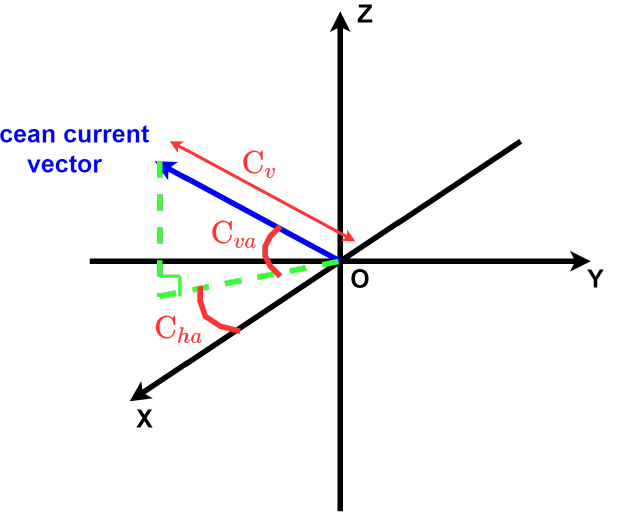
Figure 7. An example of an ocean current vector in the Gazebo reference